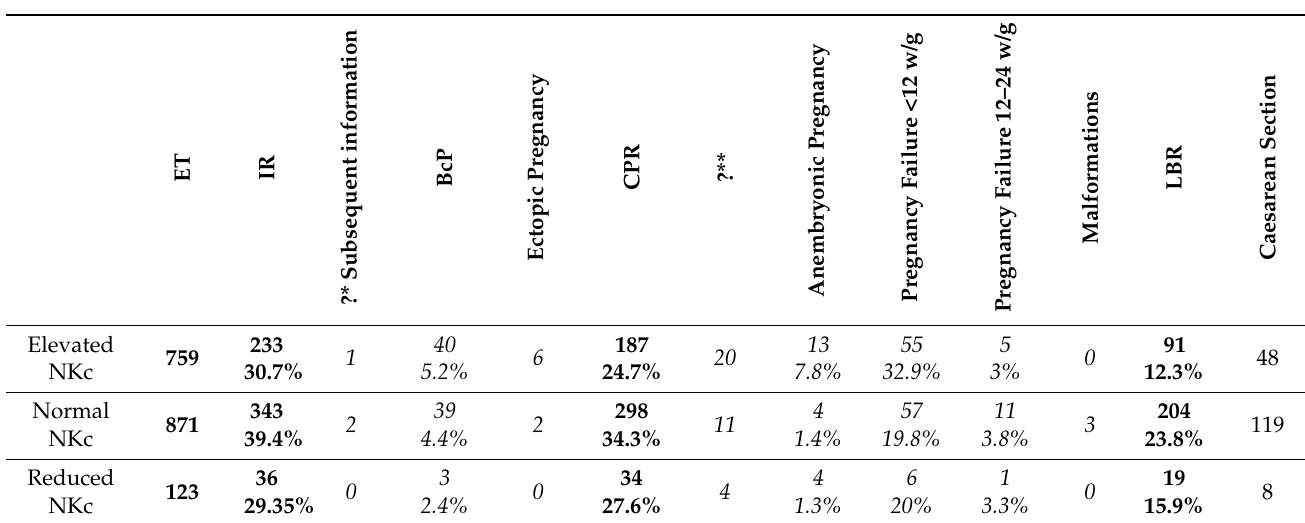
Table 2. Clinical results of IVF cycles in patients with different NKc status (BcP- biochemical